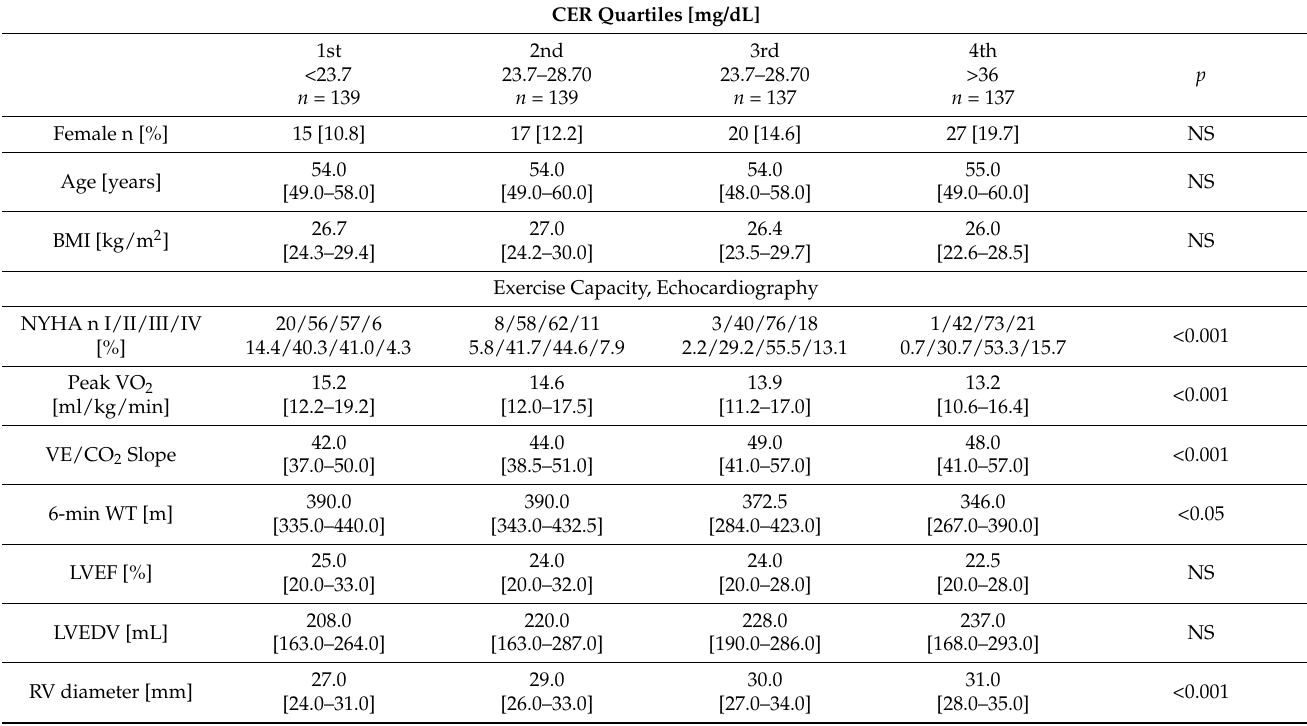
Table 2. The characteristics of the patients in the individual subgroups, depending on the CER-concentration quartiles. CER Quartiles